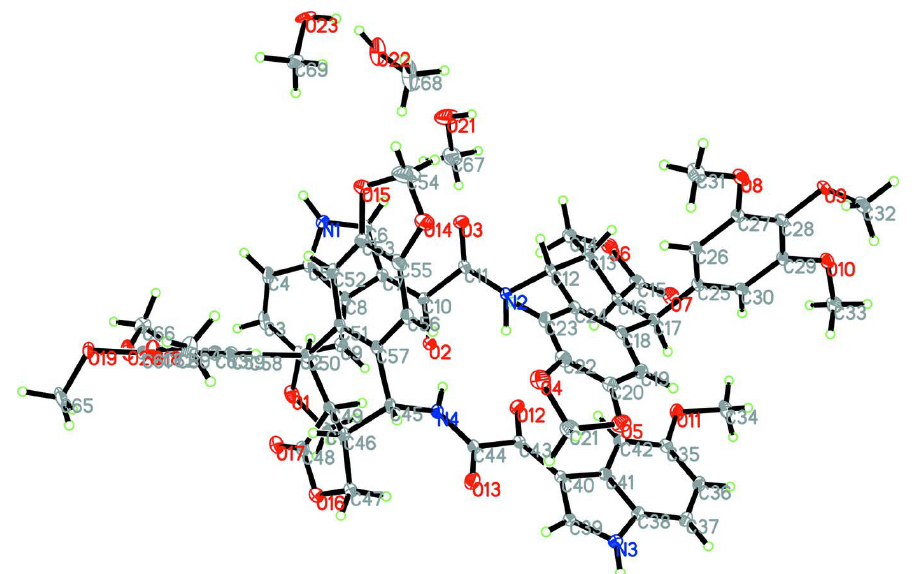
Figure 1 The molecular structure of the main molecules, with atom labels and 50% probability displacement ellipsoids for non-H atoms. The crystal is a methanol solvate, with a 1:1 composition with respect to the main molecule. Solvent molecules were